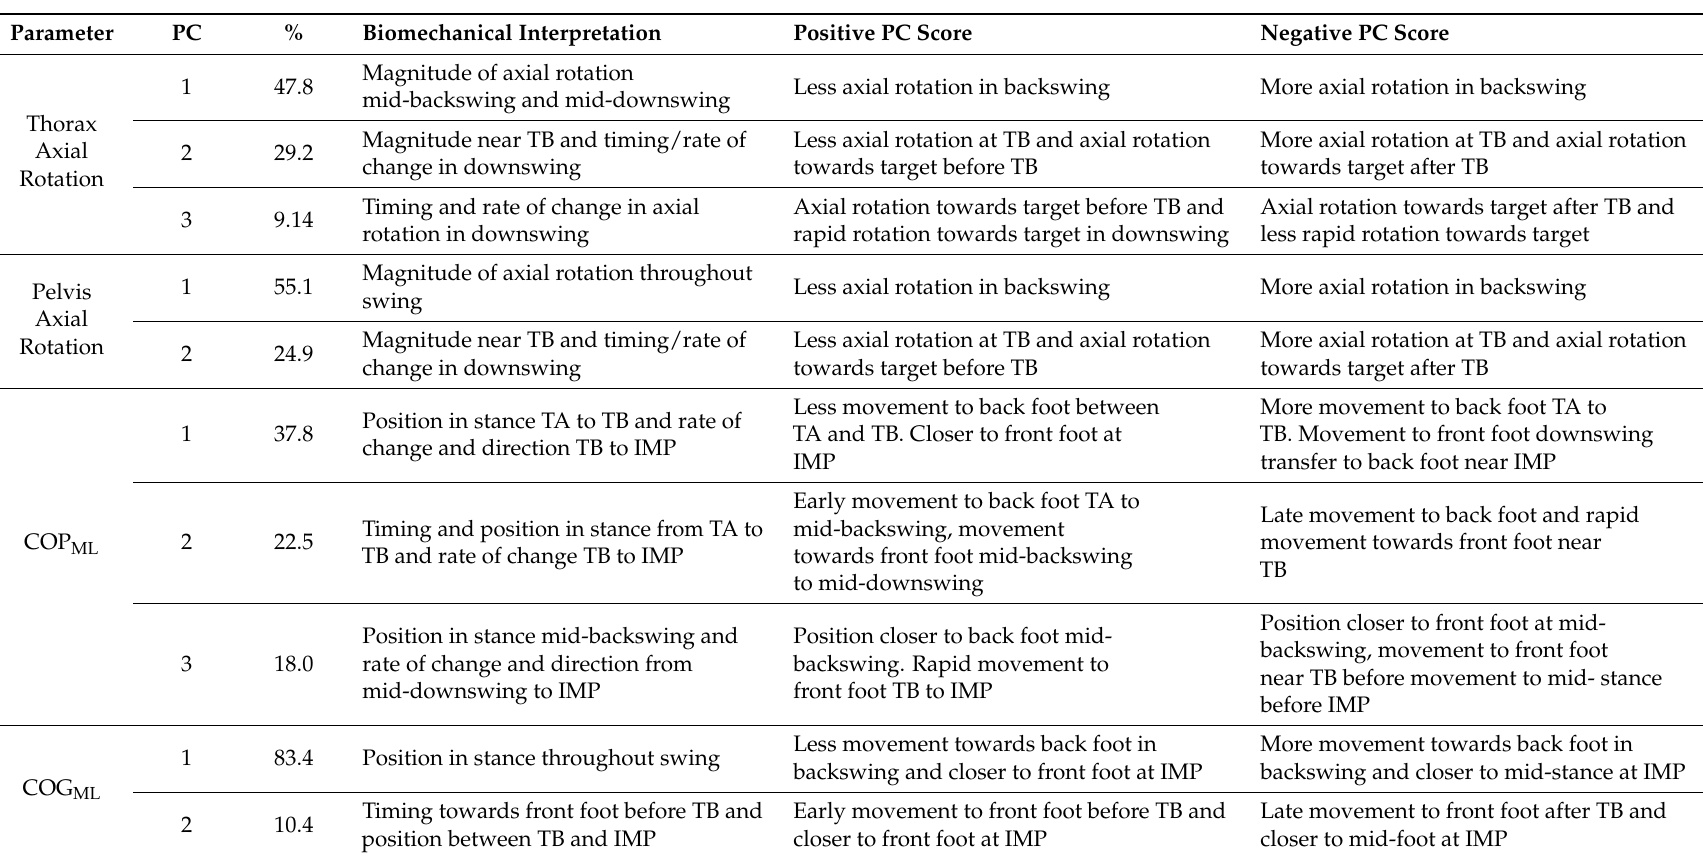
Table 1. Percentage variance explained (%), general biomechanical interpretation of thorax and pelvis axial rotation, medial-lateral COP (COP ML ), and COG (COG ML ) principal components (PCs) and positive and negative PC scores throughout the swing. TA = takeaway. TB = top of the backswing, IMP = impact. TA to TB defined as backswing and TB to IMP as